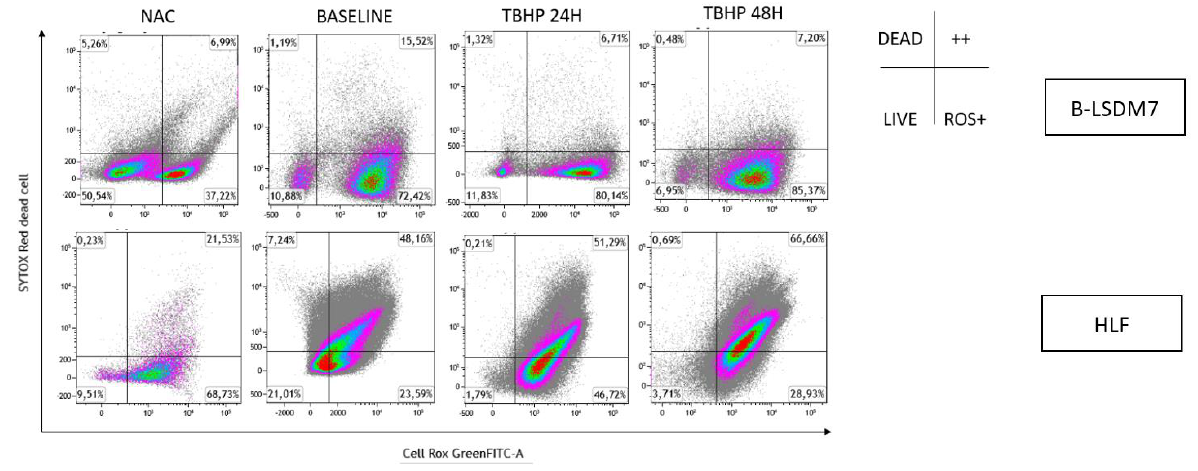
Figure 10. The detection of reactive oxygen species (ROS) and viability of cells following oxidation were performed through Flow cytometric analysis. Sytox Red was used to detect dead cells. The status of oxidation of B-LSDM and HLF were performed through CellROX® Green Flow Cytometry Assay Kits.